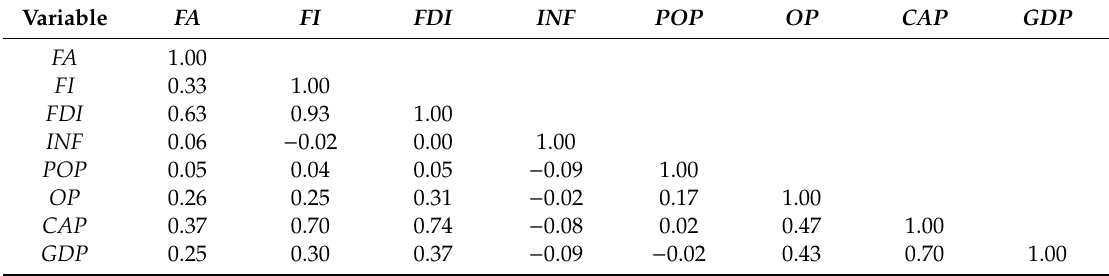
Table A2. The correlation matrix among